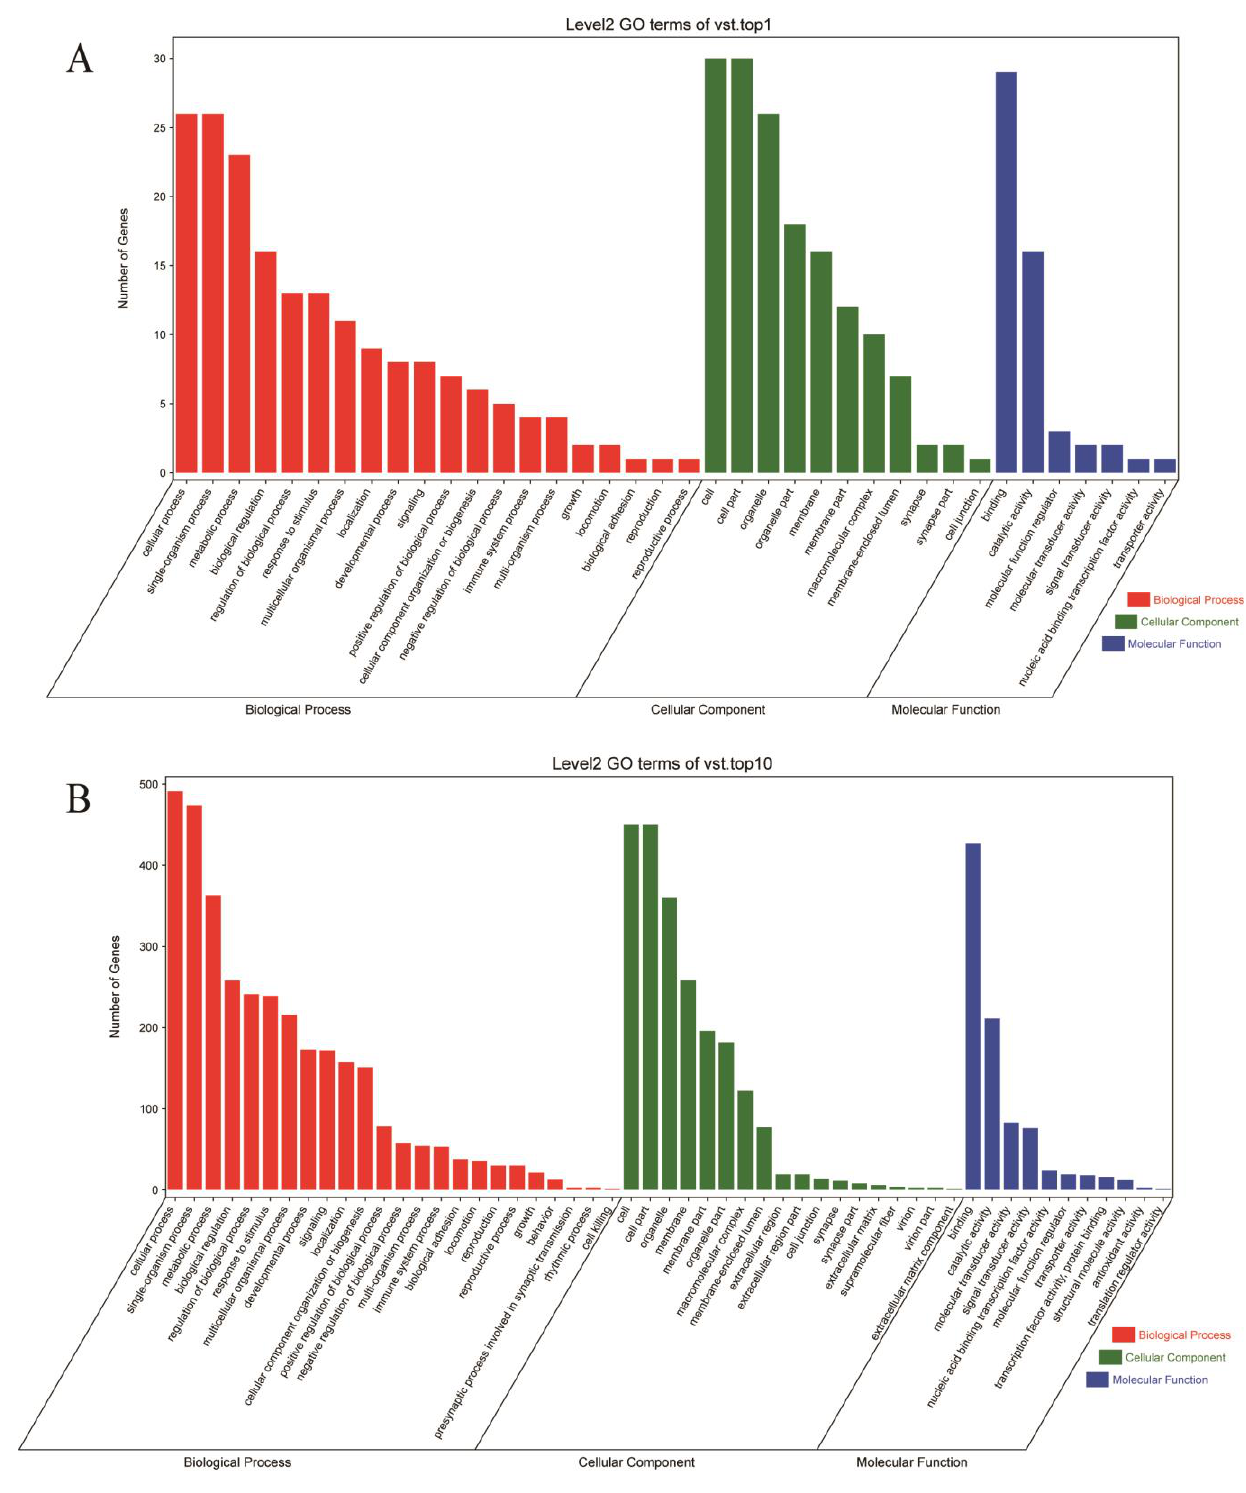
Figure 5. Gene ontology (GO) terms of enrichment of group-differential CNVRs. ( A , B ) represent GO terms of the top 1 and top 10 group-differential CNVRs, respectively; bars with different colors represent biological processes, cellular components, and molecular functions.